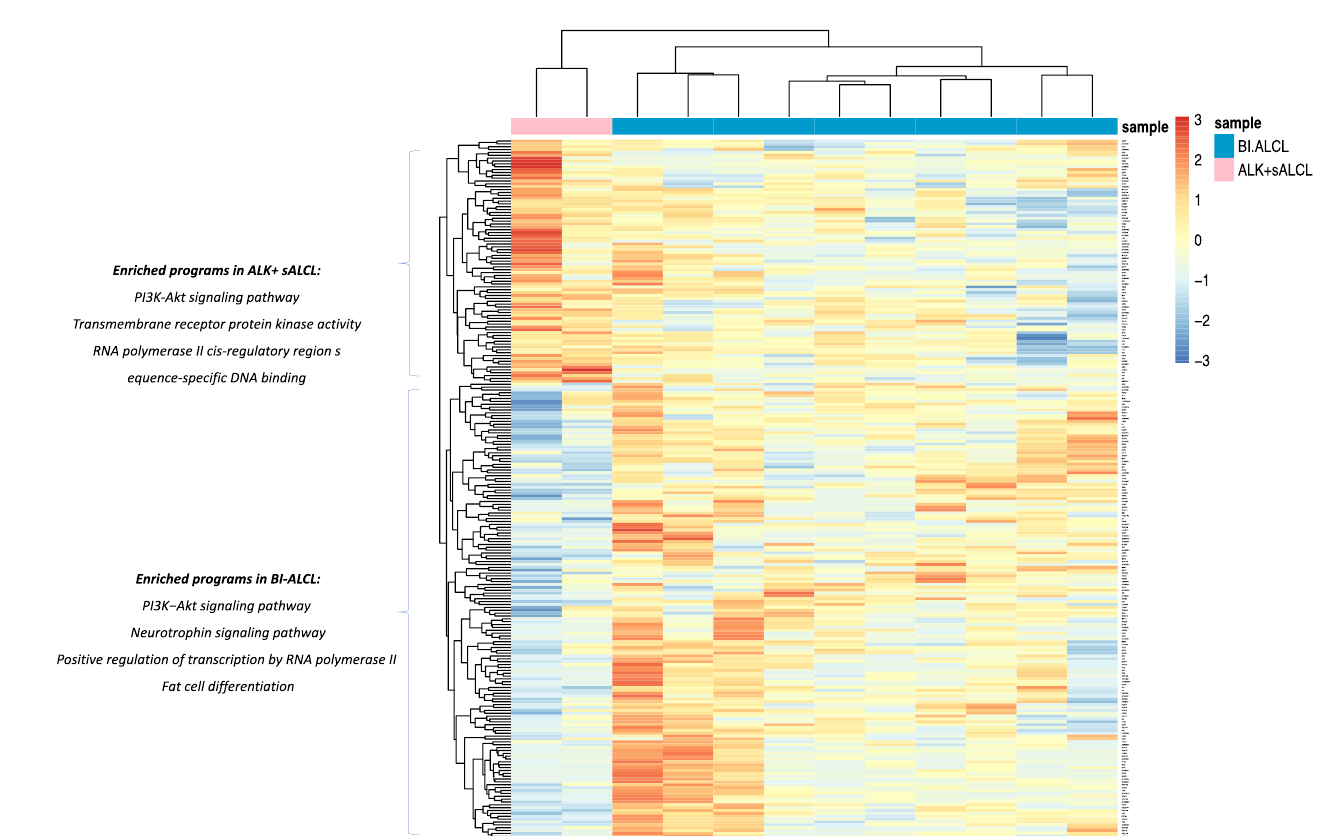
Figure 7. Heatmap showing differentially expressed genes and programs between BI-ALCLs and ALK+ sALCLs.